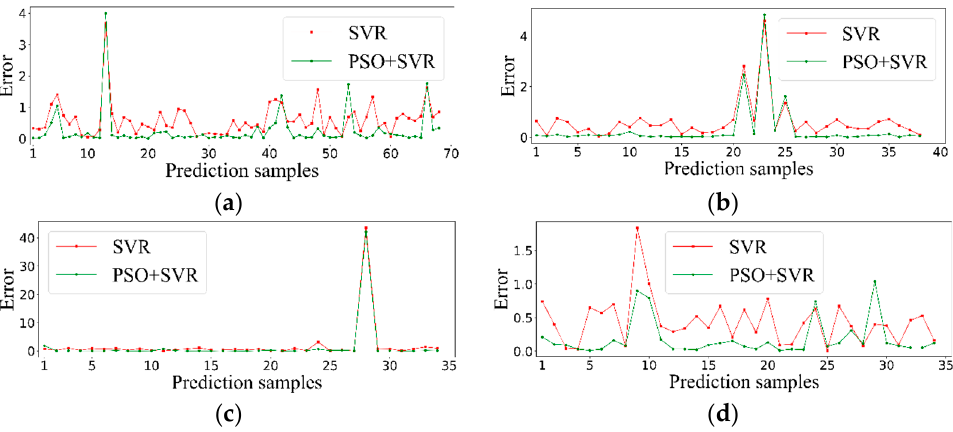
Figure 6. Prediction error provided by particle swarm optimization (PSO) + SVR (green) and SVR (red). ( a ) The prediction error of single methane. ( b ) The prediction error of single ethylene. ( c ) The prediction error of methane in mixture. ( d ) The prediction error of ethylene in mixture.